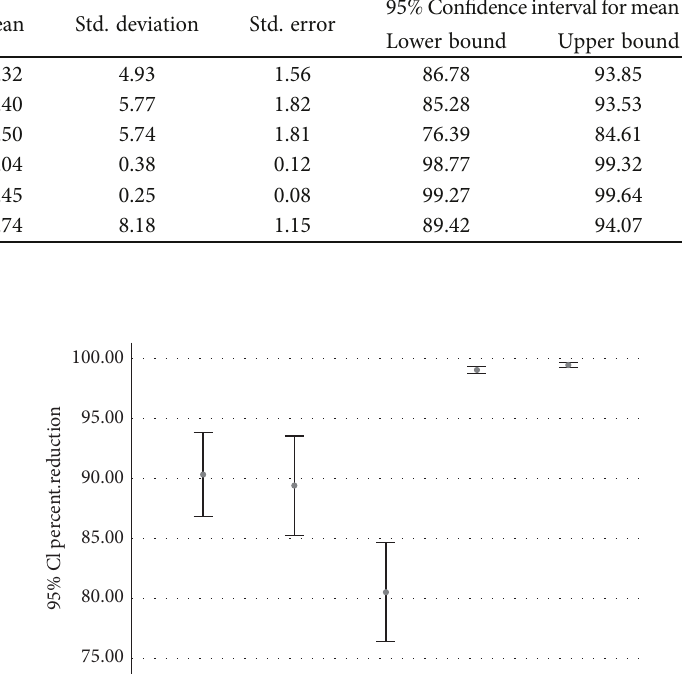
T ABLE 3: Percentage of reduction in colony count in each group after the intervention compared with baseline ( n =10). Group